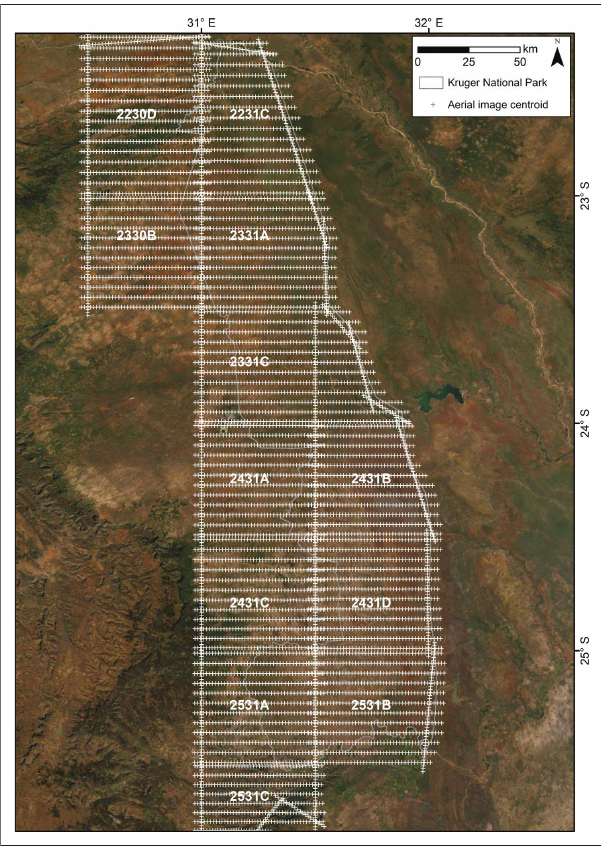
FIGURE 1: Leica digital mapping camera coverage of the Kruger National Park, South Africa represented as individual flight strip centroids for each acquisition